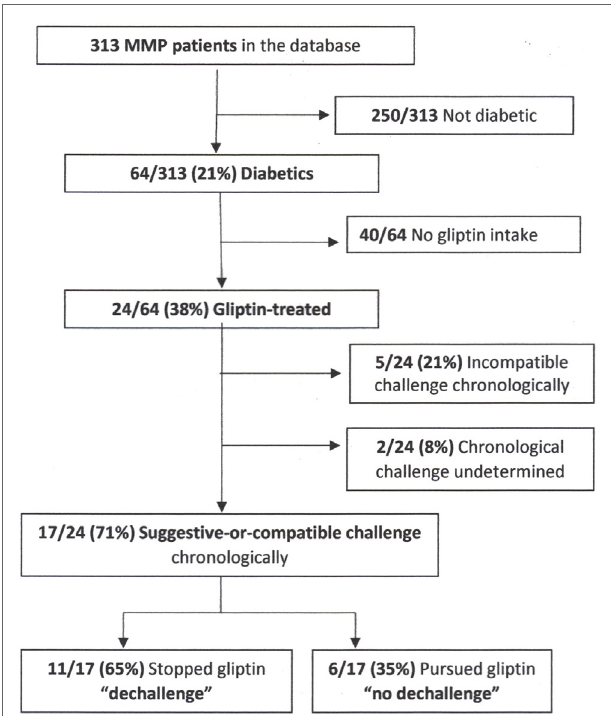
FigUre 1 | Flowchart. Abbreviation: MMP, mucous membrane